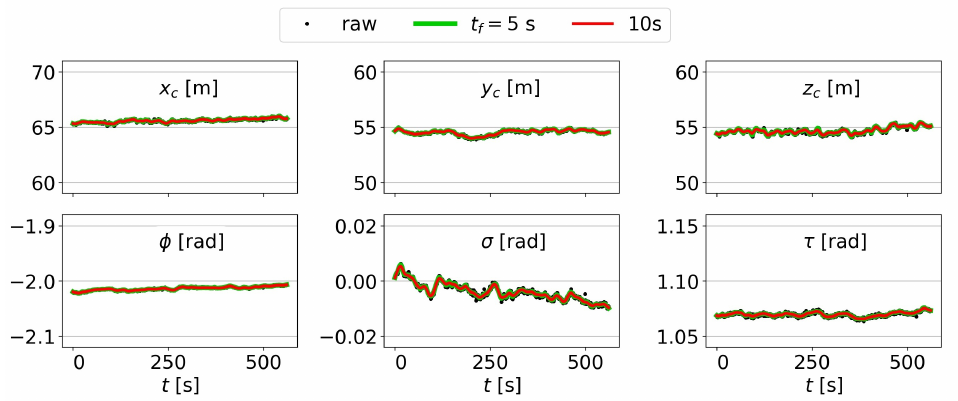
Figure 9. Extrinsic parameters obtained for video 2 (black dots), as well as interpolated and filtered results for filtering times of t f = 5s and t f = 10s.